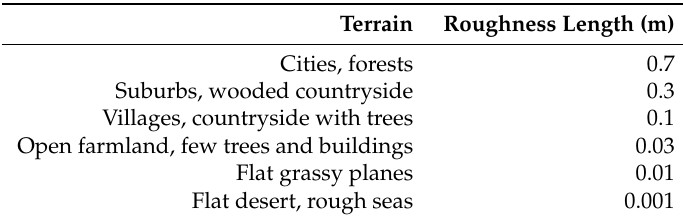
Table 1. Surface roughness lengths for various terrain types. Source:Burton et al.